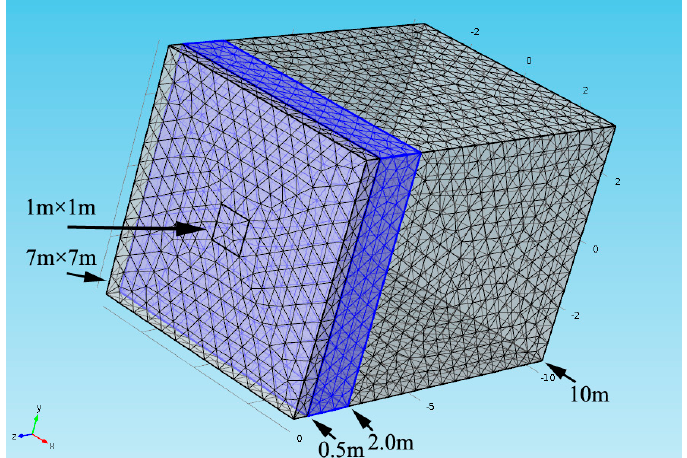
Figure 9. MRS forward model. COMSOL software is used to generate mesh and calculate magnetic field, and then MRS signal is calculated by Equation (6). The surface of cube is the boundary of the magnetic field and the blue layer represents the aquifer.